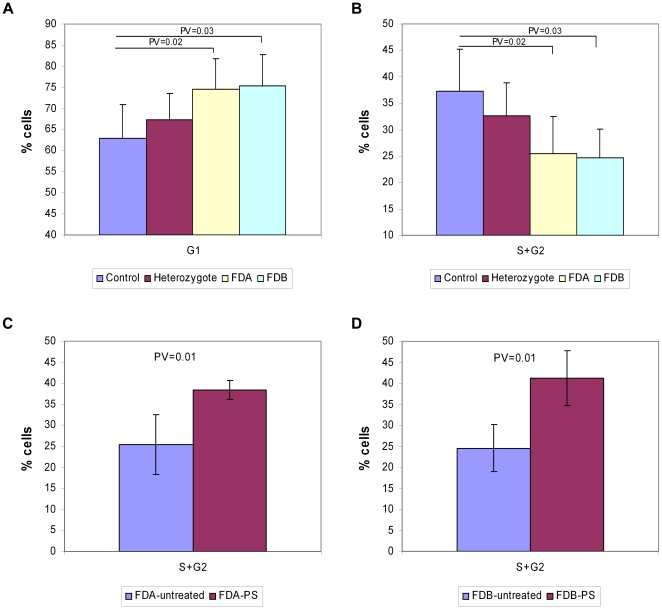
PS alters the cell cycle distribution of FD cells.One day prior to treatment 750,000 cells were seeded. The cells were treated with 100 µg/ml PS for 24 hr and then fixed and stained with PI according to the flow cytometry protocol. The percentage of cells (A) at the G1 stage and (B) at the growth stages, S+G2, of untreated control, heterozygous, FDA and FDB cells. The percentages of cells at the growth stages, S+G2, of (C) FDA or (D) FDB cells following PS treatment compared to untreated FD cells. All experiments were repeated independently four times, and the results shown are mean values ± SD. P-values of significant results are indicated.